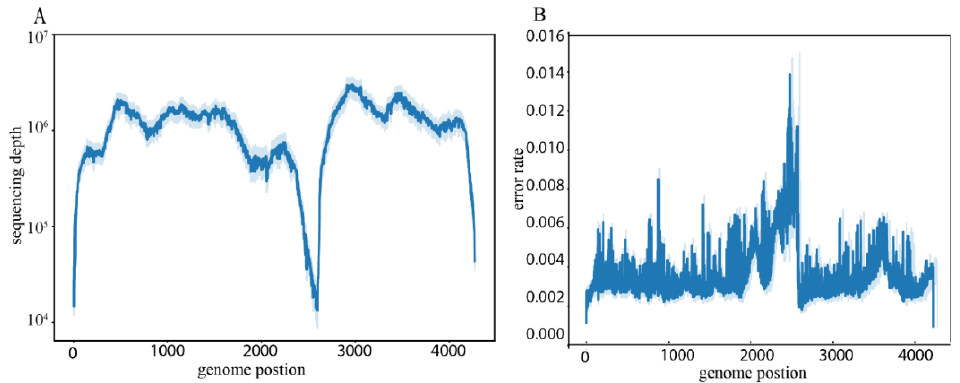
Figure 1. Overall description of the sequencing information in this study (mean lines with confidence interval bands). Dark blue represents the mean line, and light blue areas represent confidence intervals. ( A ) Sequencing depth along the genome coordinate. ( B ) Sequencing error rate along the genome coordinate.